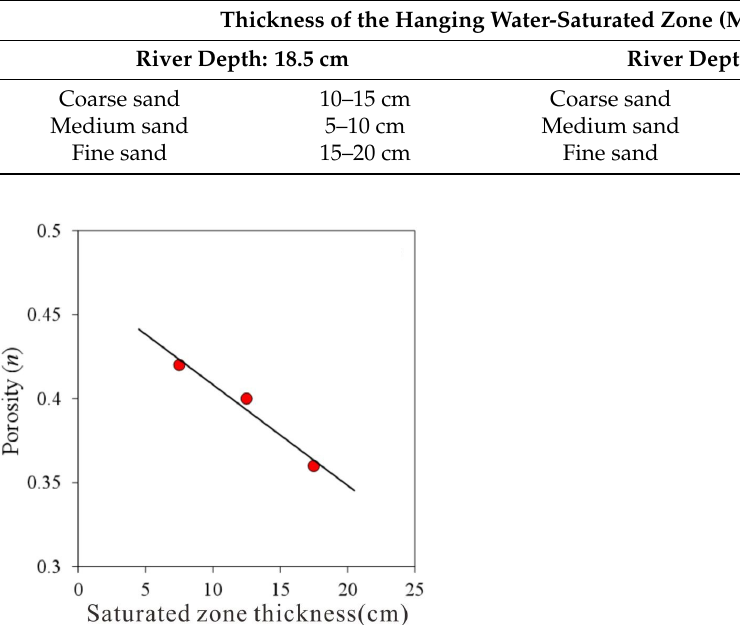
Table 2. Thickness of the inverted saturated zone under different river depths and aqueous media.